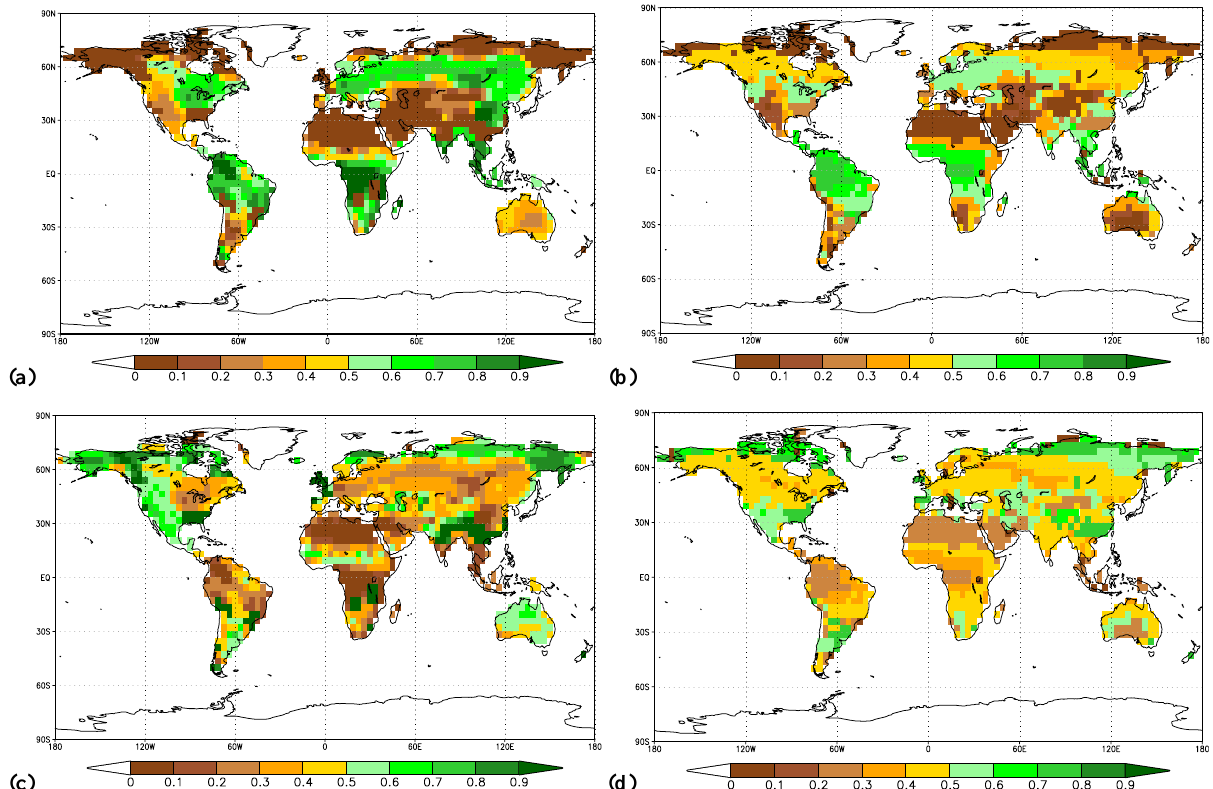
Fig. A1. Comparison of the standard vegetation forcing, as used in the PlioMIP PI simulation of experiment 1, to a smoothed PI vegetation cover: Forest fractions for the standard (a) and smoothed (b) vegetation, and grass fractions for the standard (c) and smoothed (d) vegetation.